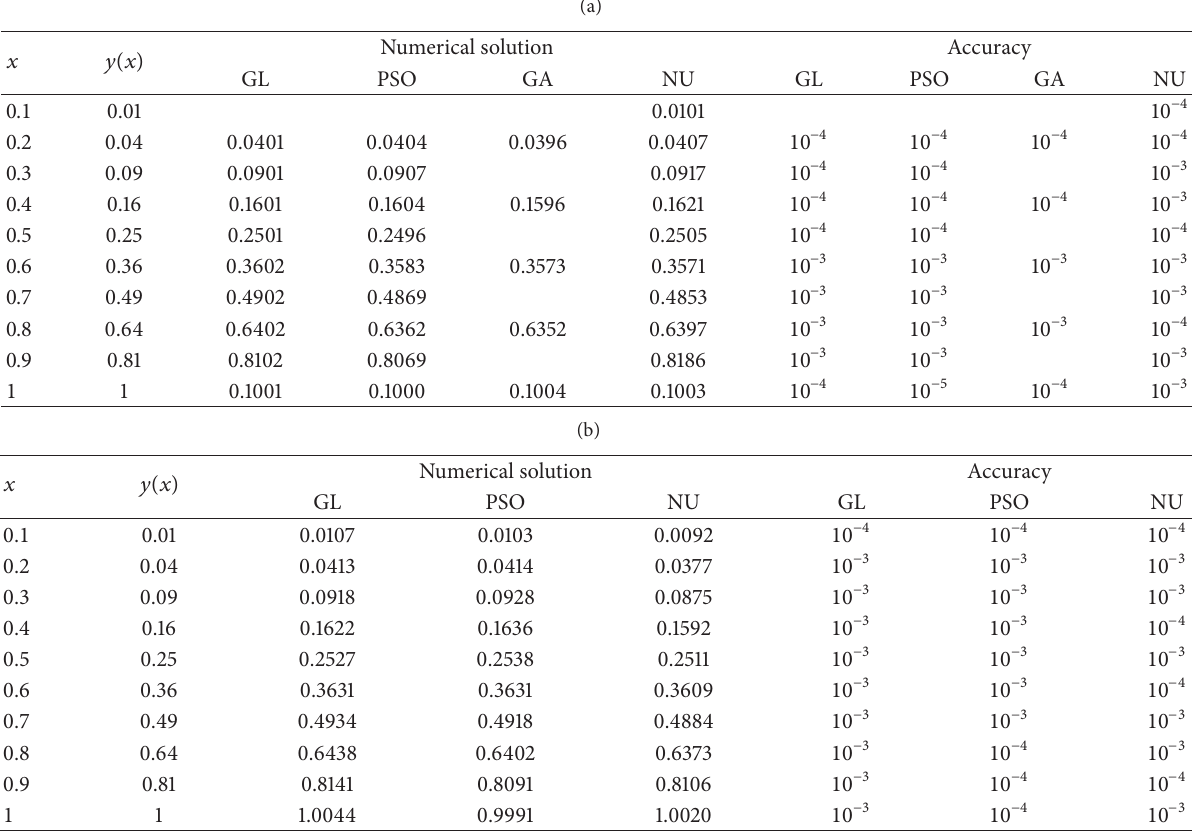
Table 2: (a) Comparison of results for the solution of Example 1 for 𝛼 = 0.5 . (b) Comparison of results for the solution of Example 1 for 𝛼 = 0.75 .